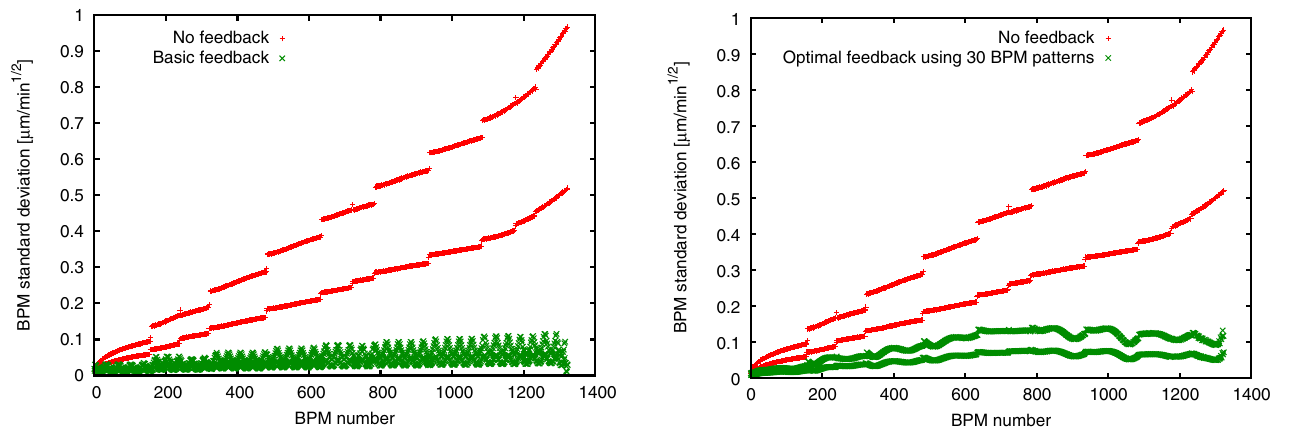
FIG. 9. (Color) Theoretical standard deviation of BPM readings for a large number of seeds. Without feedback the trajectory deviation at the end of the linac is of the order of a (cid:3) m after 1 min. The basic feedback system based on 1324 BPMs and 80 dipole corrector efficiently reduces the